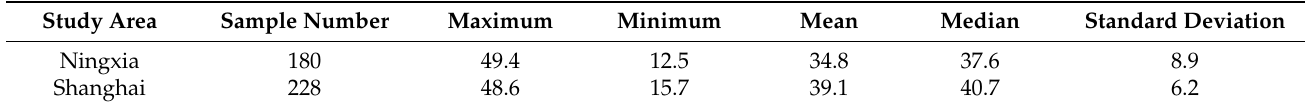
Table 3. Statistical characteristics of rice LCC in Ningxia and Shanghai.